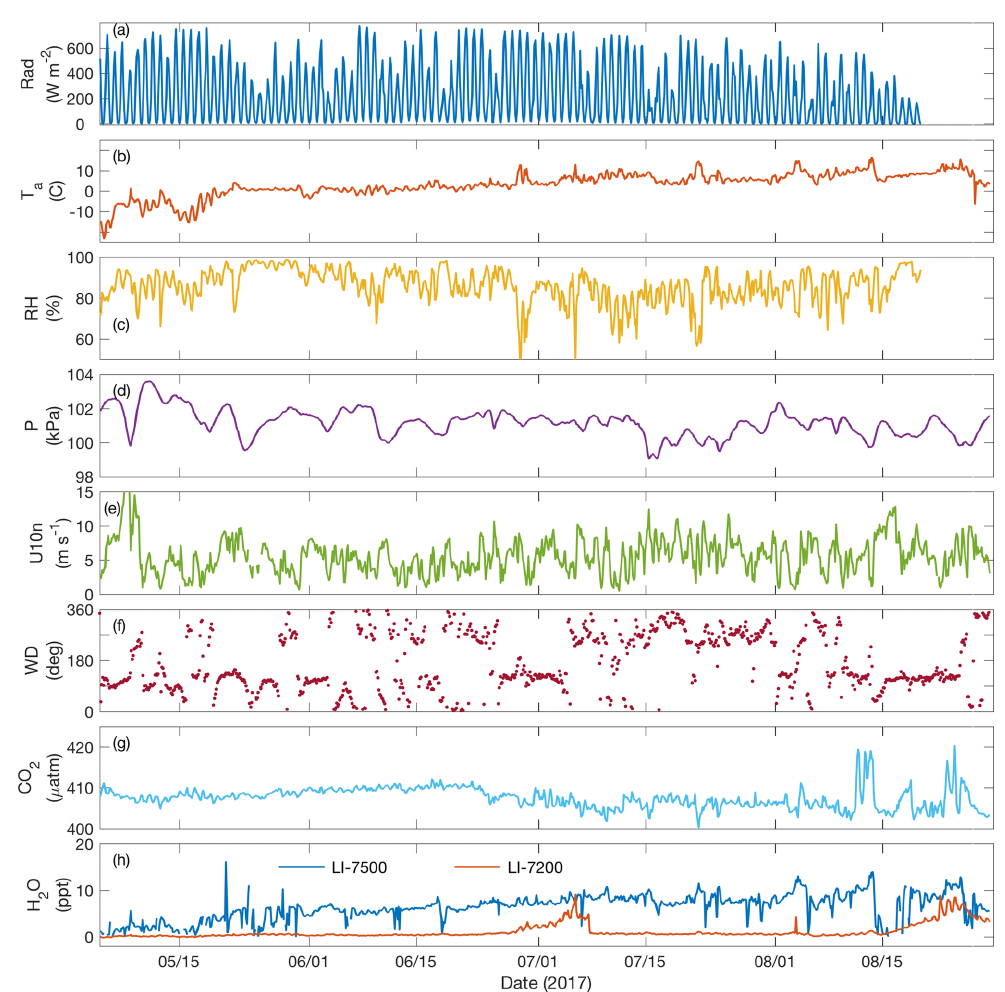
Figure 6. Meteorological conditions from May to September 2017 shown as 3h averages for (a) incoming solar radiation (Wm − 2 ), (b) air temperature ( ◦ C), (c) relative humidity (%), (d) atmospheric pressure (kPa), (e) wind speed (ms − 1 ), (f) wind direction ( ◦ ), (g) CO 2 mixing ratio (ppm), and (h) water vapor concentration